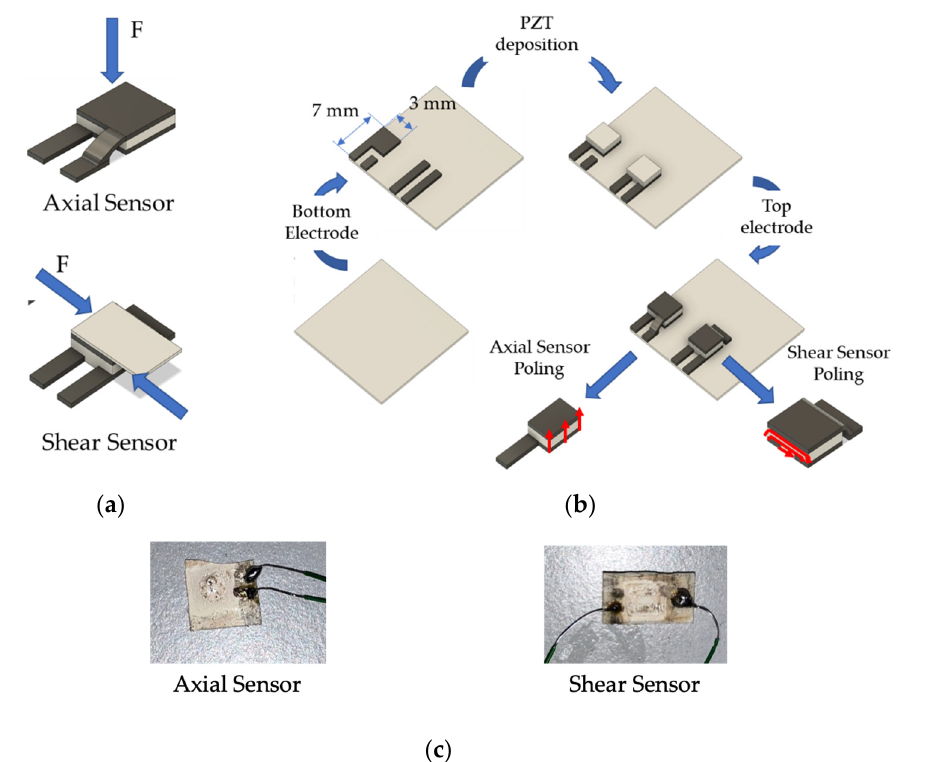
Figure 2. ( a ) Loading direction for axial and shear sensors; ( b ) Block diagram of the production process. ( c ) Axial and shear sensors.